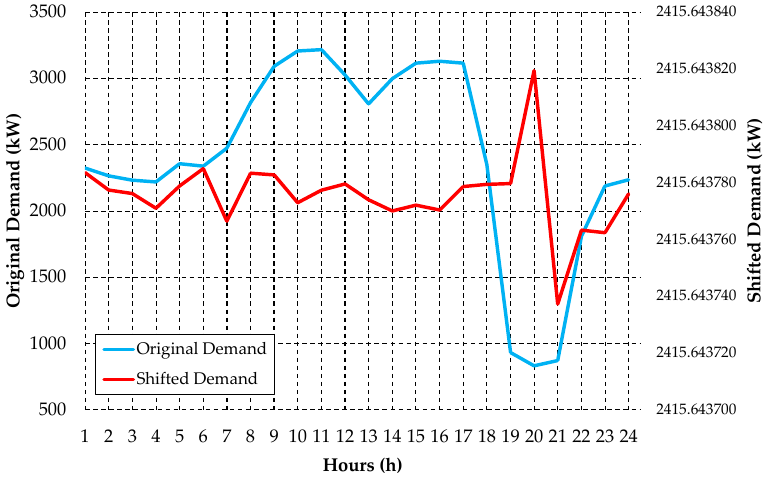
Figure 13. Daily demand profile of irrigator customers resulting from load shifting at the Rural Feeder A. Source: The authors.